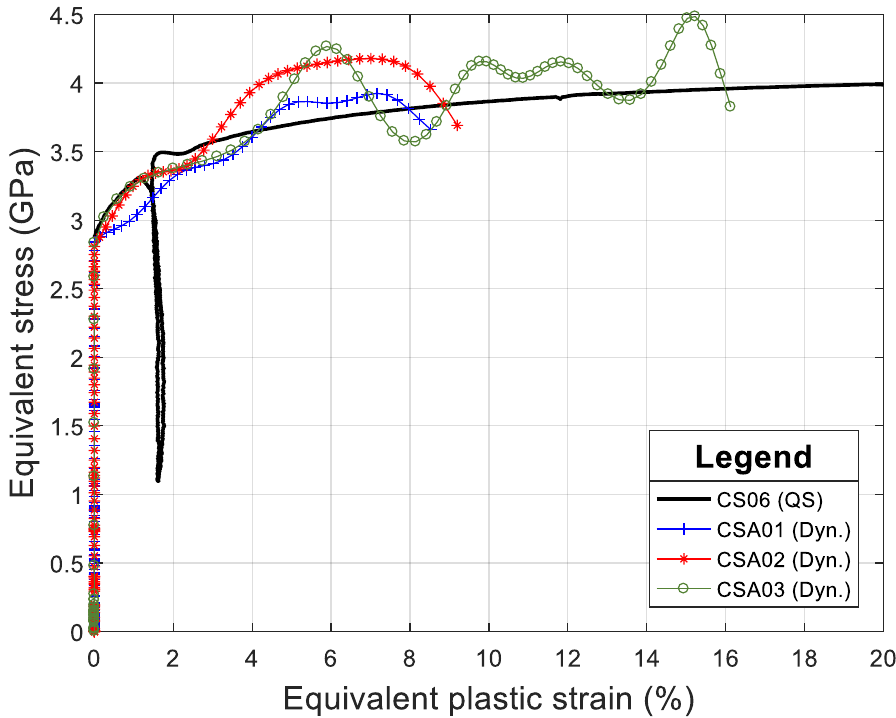
Figure 16. Equivalent stress versus equivalent plastic strain response: comparison of quasi-static and dynamic tests.